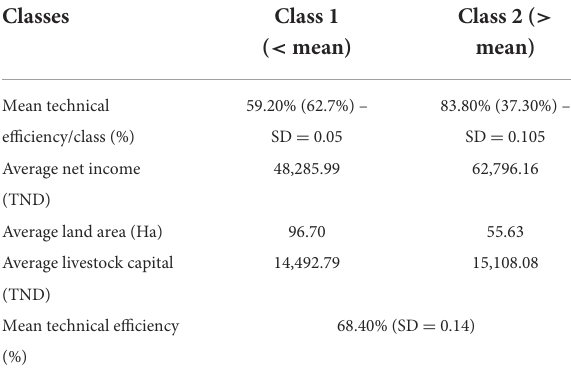
TABLE 3 Frequency distribution of technical efficiency for CA adopter